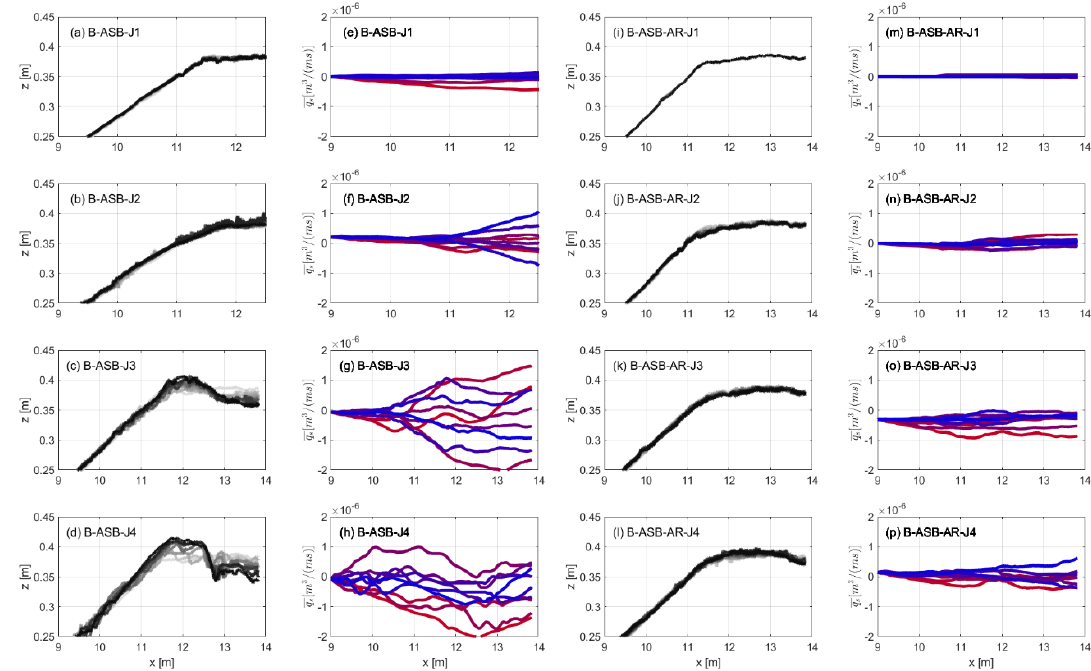
Figure 8. The profile and the sediment transport of the fore-slope and the partial crest of the ASB: panels ( a – d ) and ( i – l ) show the profile captured every 10 min with colors changing from light to dark as time passes; panels ( e – h ) and ( m – p ) illustrate the sediment transport rate every 10 min with colors changing from red to blue as time passes.